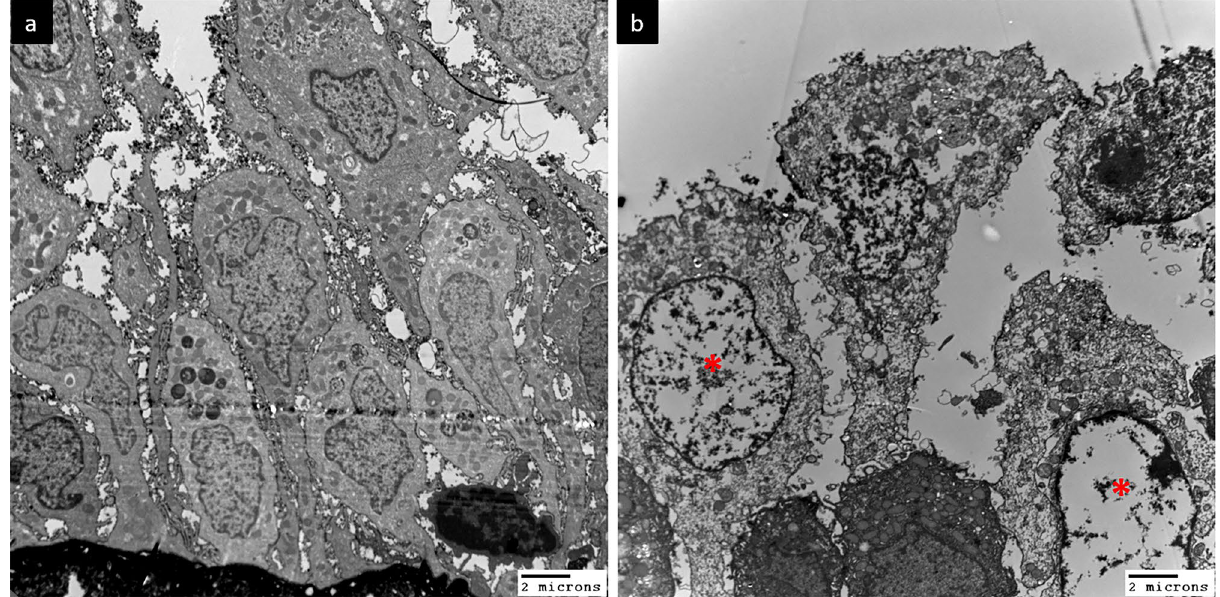
Figure 4. Apoptosis-like morphological changes in urothelial samples from patients. ( a ) Urothelial cells with normal organelles and nuclei. ( b ) Urothelial cells with swollen nuclei (asterisks) and ruptured